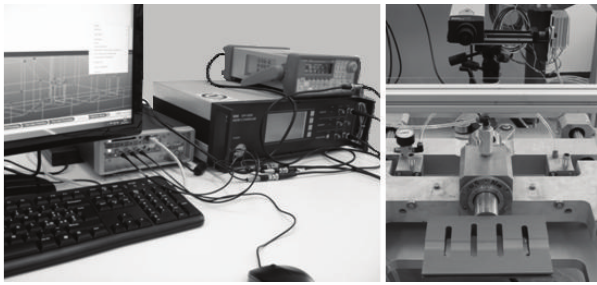
Figure 4: Experimental setup.